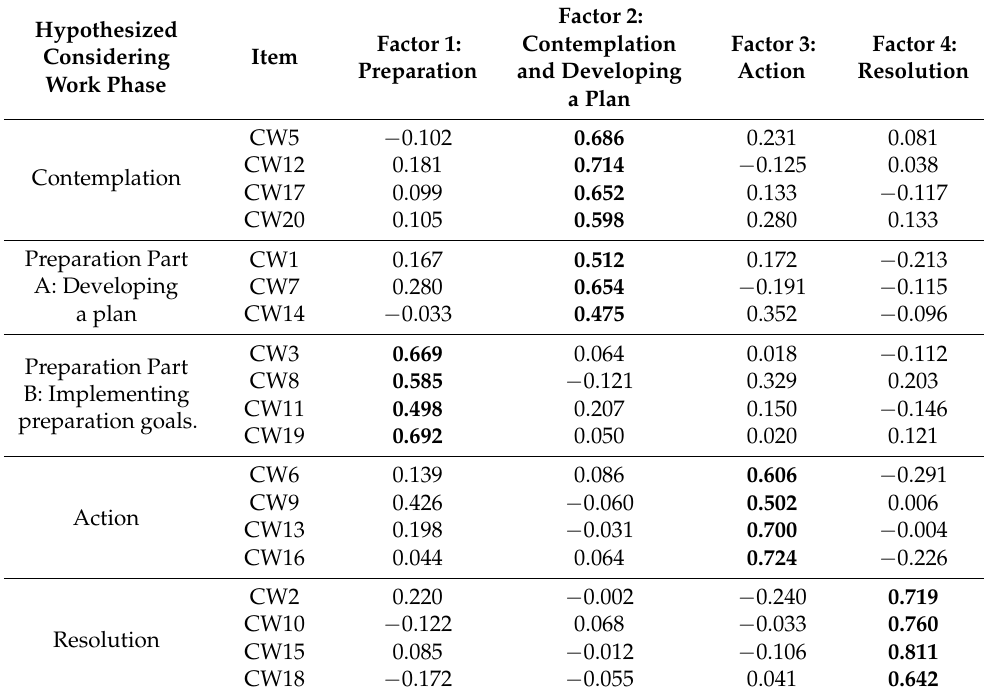
Table 3. Four-factor solution using the CF-Equamax